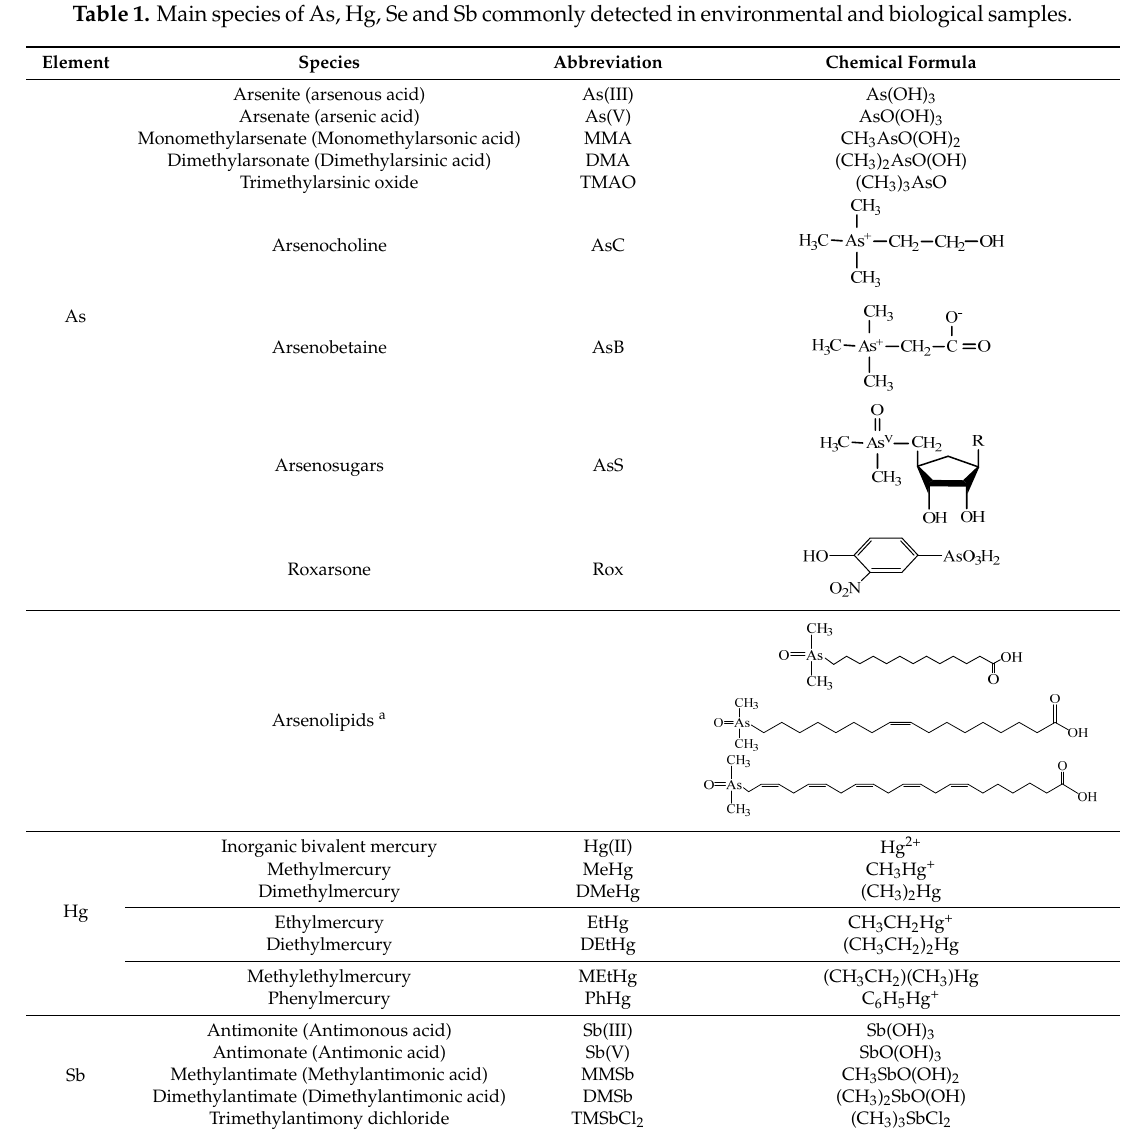
Table 1. Main species of As, Hg, Se and Sb commonly detected in environmental and biological samples. Element Species Abbreviation Chemical Formula